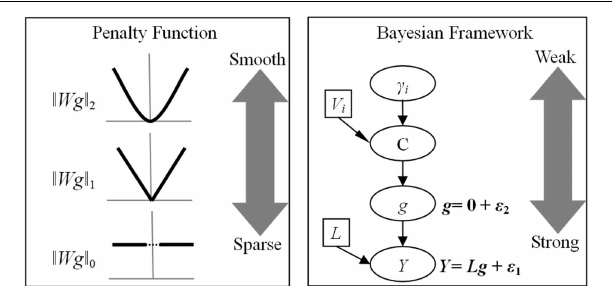
FIGURE 2 | Relationship between penalty function and Bayesian model. The advantages of penalty function are the configurable norm and the weight matrix. In contrast, Bayesian model has a hierarchical structure, which yield different influence on the final solution. k Wg k p is a penalization function with l p -norm, W i is a weight matrix imposing different type of constraint and g is the unknown source activity. While most studies set p = 2 to employ l 2 -norm, recently developments proposed both l 1 and l 0 norms to obtain the sparse solutions. Y is the EEG recording and L is the known lead-field matrix. ε 1 and ε 2 obey multivariate Gaussian distributions, representing random fluctuations in sensor and source spaces, respectively. The spatial covariance of g , C, is mixtures of covariance components ( V i ) and hyperparameters ( γ i